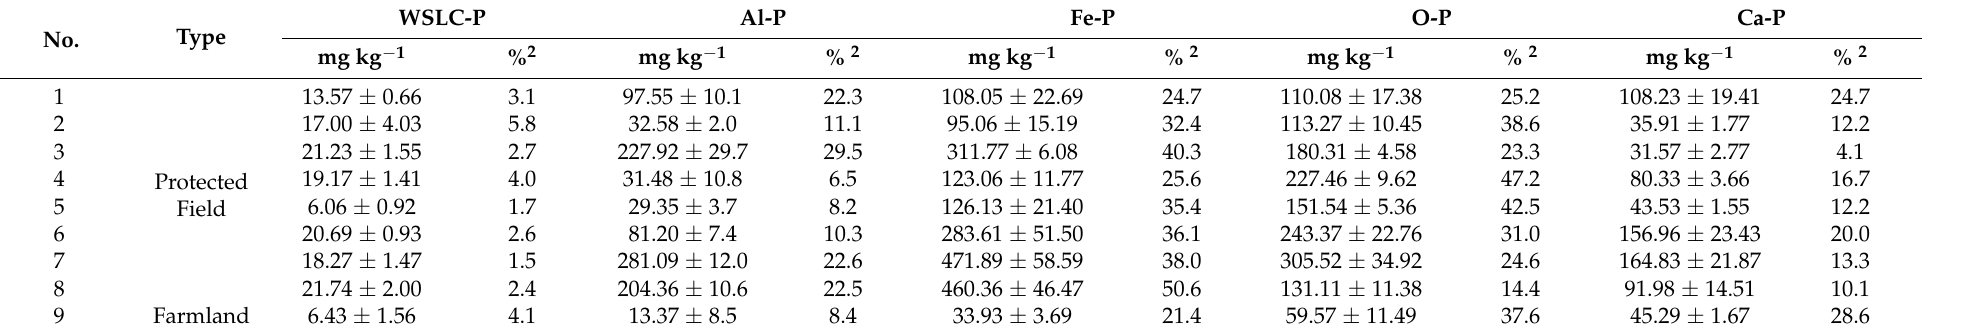
Table 5. The composition of inorganic phosphorus in the 20–40 cm layer of soils collected from protected fields 1